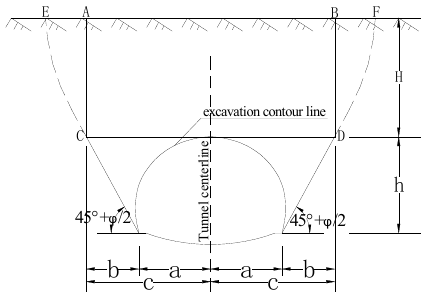
Figure 3. Calculation diagram of grouting range. ( φ is the internal friction angle . a is the half width of tunnel. b is the sliding width. h is the height from the tunnel arch foot to the vault. H is the height from tunnel crown to ground.)